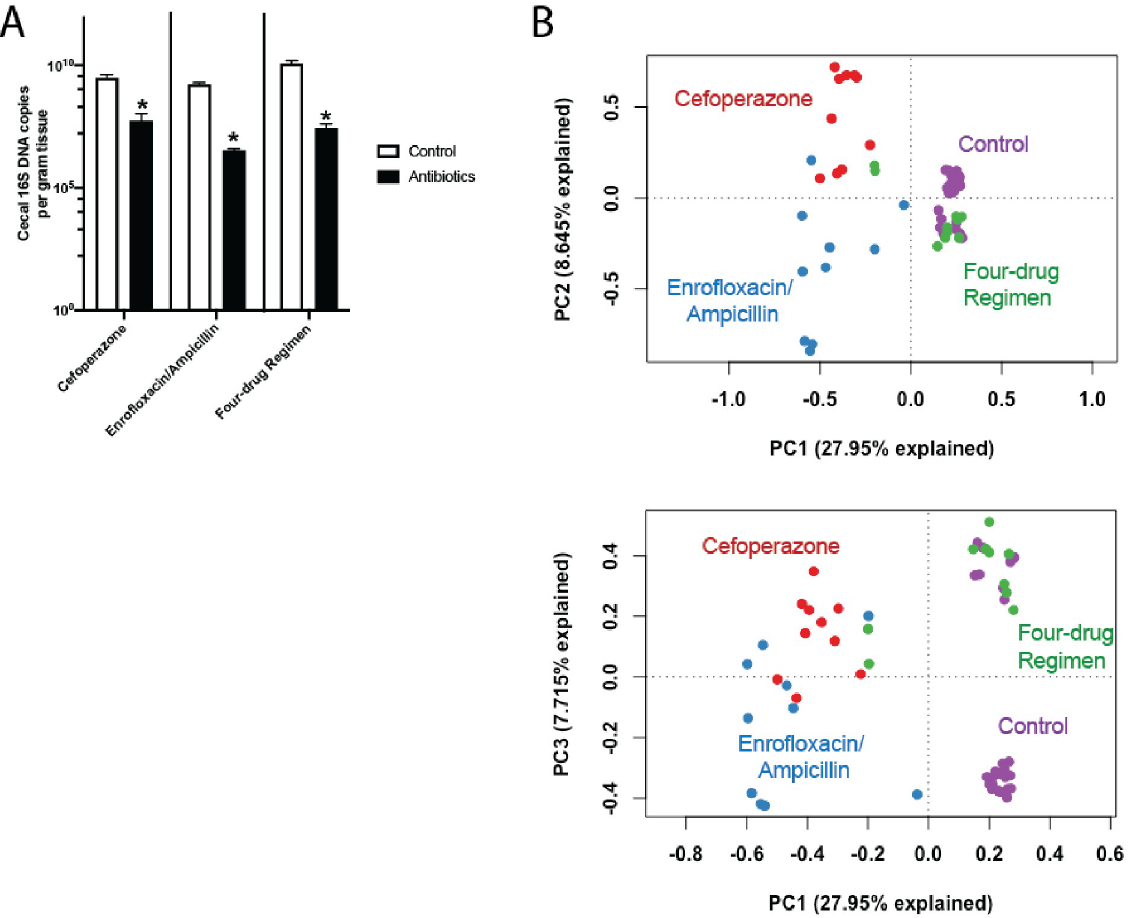
Fig 3. Effects of oral antibiotic regimens on cecal bacterial density and community composition. Mice were administered enteral antibiotics via distilled drinking water (cefoperazone, enrofloxacin/ampicillin, or the four-drug regimen); control mice were administered distilled drinking water alone. Mice were provided ad libitum access to food and water and harvested on day 8. (A) Comparison of 16S bacterial DNA copy number in mouse cecal tip. n = 10, � P < 0.05. Error bars denote SEM. (B) PCA plots of microbiota in mouse cecum. Each dot represents one mouse. Gut communities of all antibiotic-treated groups were significantly distinct from those of control mice as well as each other ( P < 0.0001 for all comparisons, PERMANOVA). Top : Graph of PC1 versus PC2. Bottom : Graph of PC1 versus PC3.